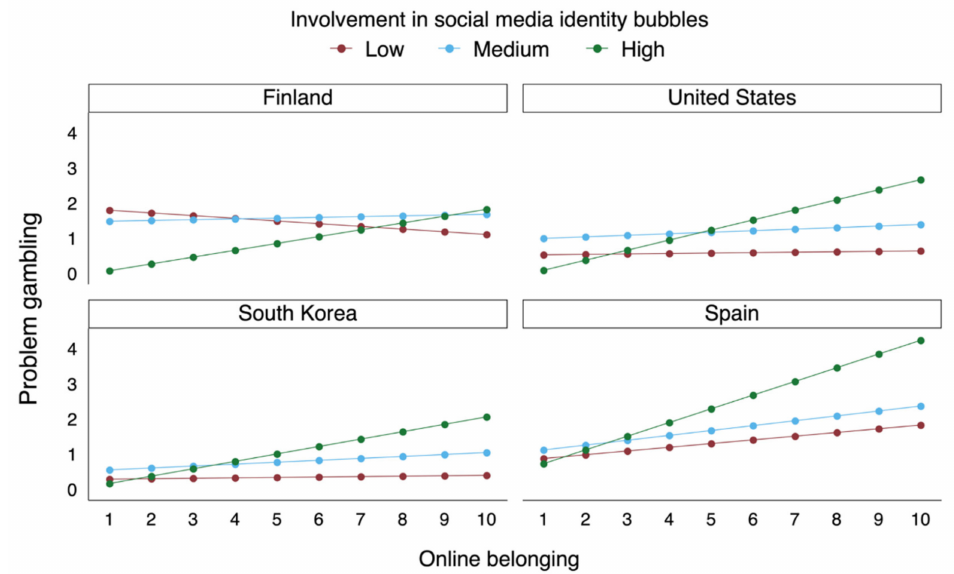
Figure 1. Adjusted predictions depicting the interaction between belonging to online communities and involvement in social media identity